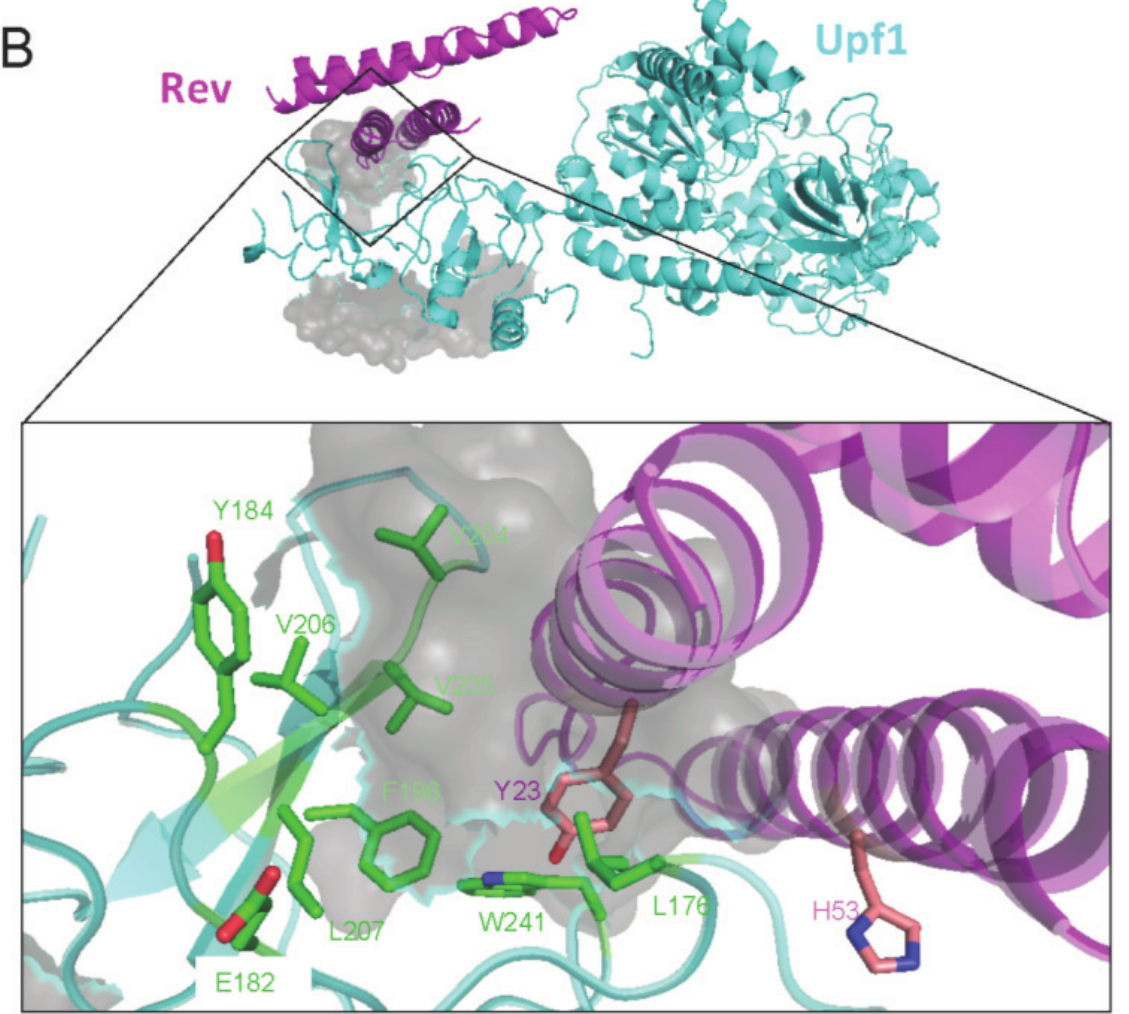
Figure 5. Interaction models and a mechanism for UPF2 exclusion. ( A ) Structural model for the interaction between UPF1 (cyan) and DDX3 (yellow) and structural alignment with the UPF1-UPF2 complex. UPF2 is represented as a gray surface (upper). An amplified image of the model for the UPF1-DDX3 complex is presented (bottom). Relevant residues obtained for UPF1 (orange) and DDX3 (pink) through alanine scanning or described in previous work as relevant for interaction with UPF2 (green) are shown as sticks. ( B ) Structural model for the interaction between UPF1 (cyan) and Rev (magenta) and structural alignment with the UPF1-UPF2 complex. UPF2 is represented as a gray surface (upper). An amplified image of the model for the UPF1-Rev complex is presented (bottom). Relevant residues obtained for UPF1 (orange) and Rev (pink) through alanine scanning or described in previous work as relevant for interaction with UPF2 (green) are shown as sticks. Drawing was performed with the Pymol software as described in materials and